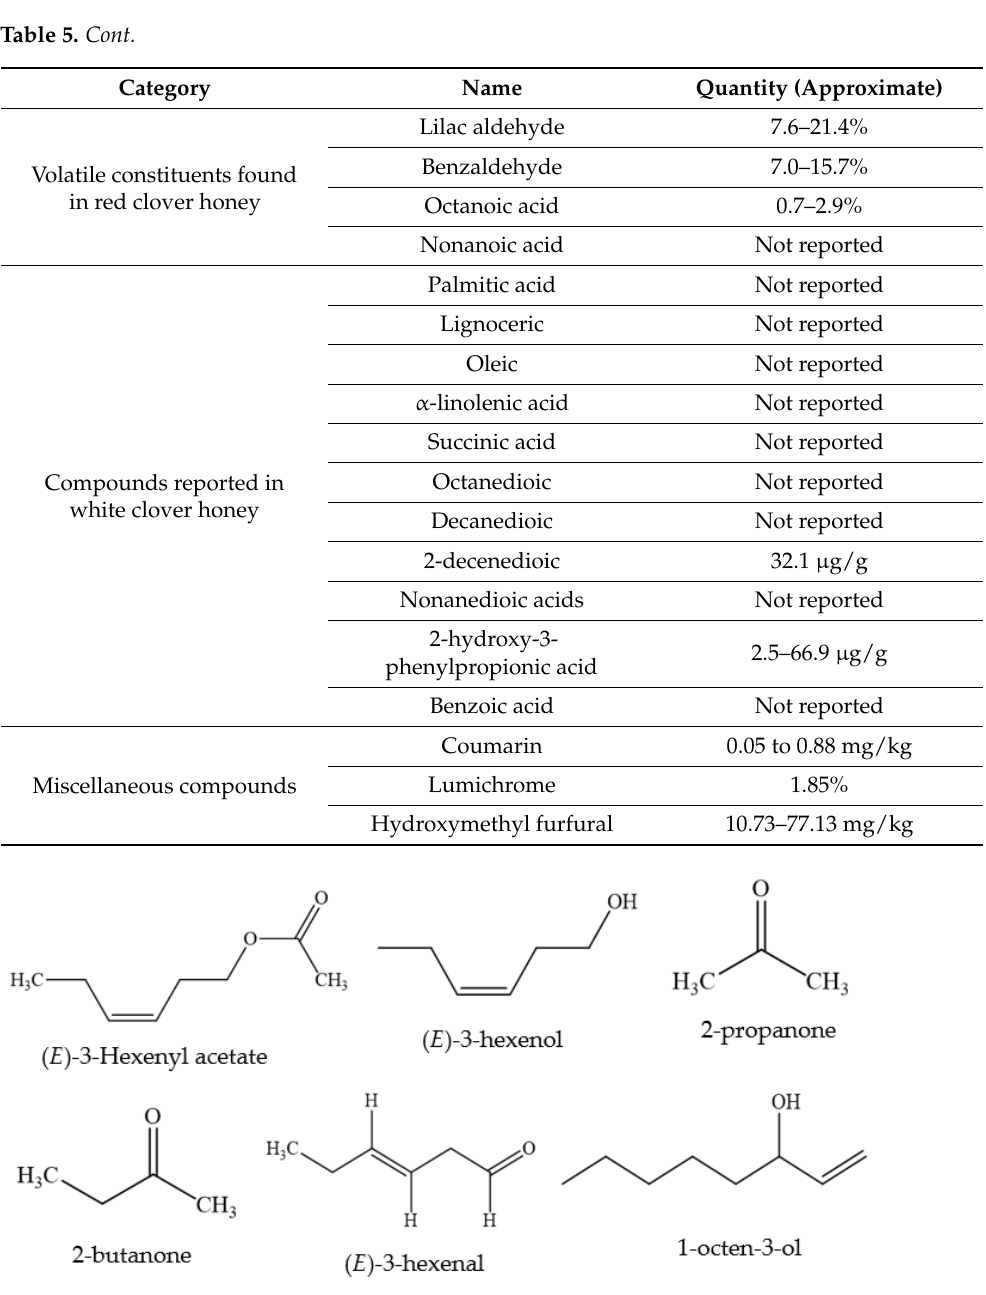
Figure 7. Volatile components reported in Clover plants.